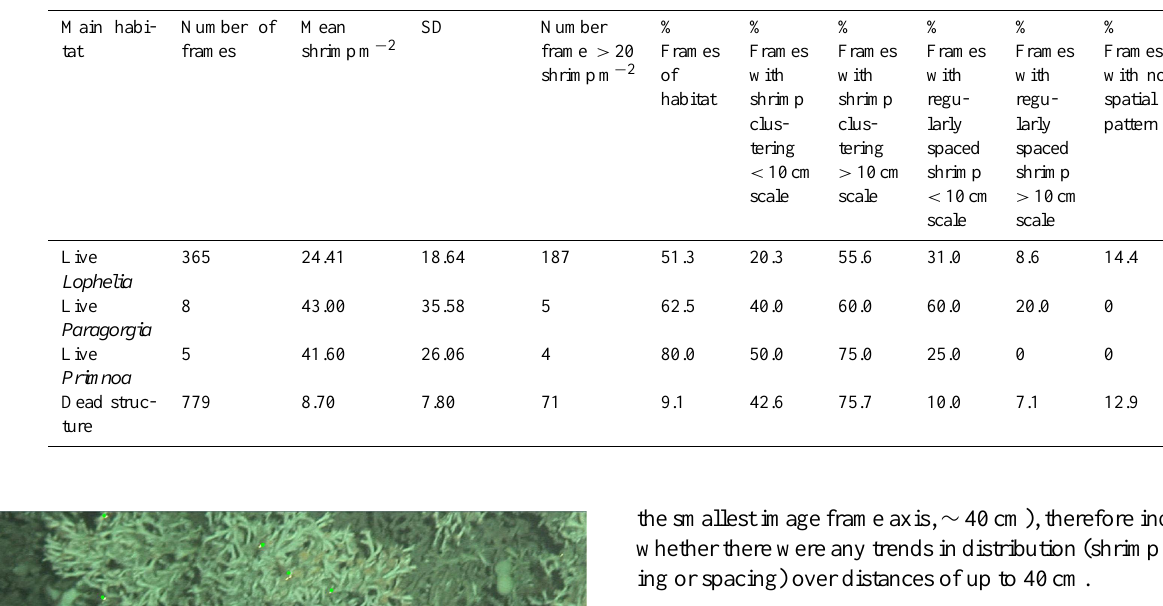
Table 2. Table summarising the local ( < 40cm scale) shrimp distribution patterns observed in image frames containing > 20 shrimp. The number of frames taken above the > 50% live Lophelia pertusa , live Paragorgia arborea , live Primnoa resedaeformis and > 50% dead structure categories with > 20 shrimp present is indicated. Insufficient shrimp were observed in association with the other habitat categories investigated to allow for computation of Ripley’s L.